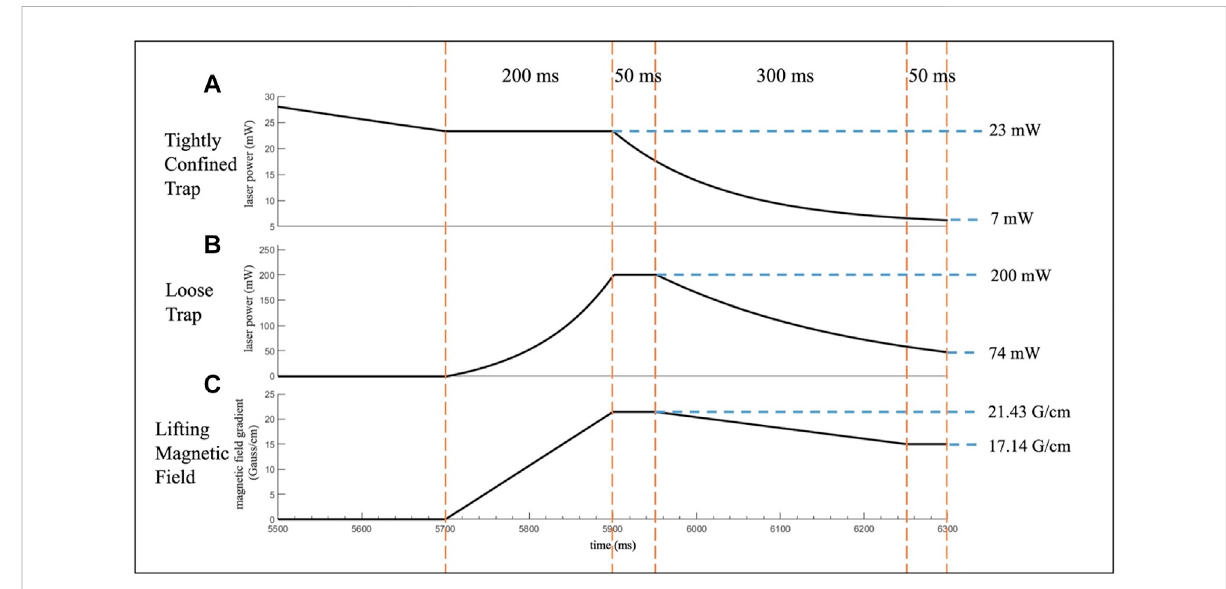
FIGURE 5 Experimental parameter settings for the two-stage cooling scheme in the ground veri fi cation experiments towards Chinese space station. Illustrations (A,B) show the variation of laser power with time for the thin-waisted ODT and the thick-waisted ODT, respectively, during